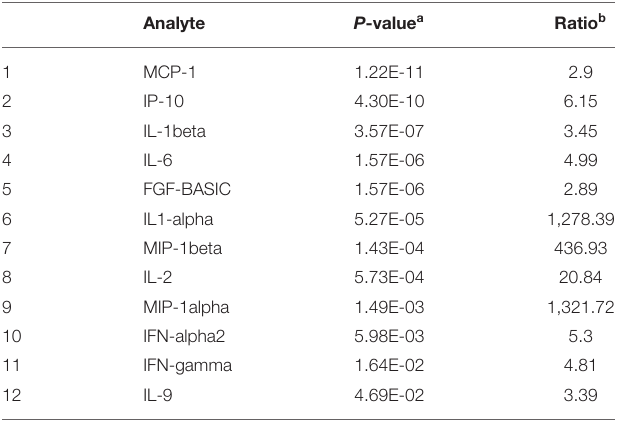
TABLE 2 | Analytes found to be significantly changed by Ag stimulation, that were retained for further analysis.